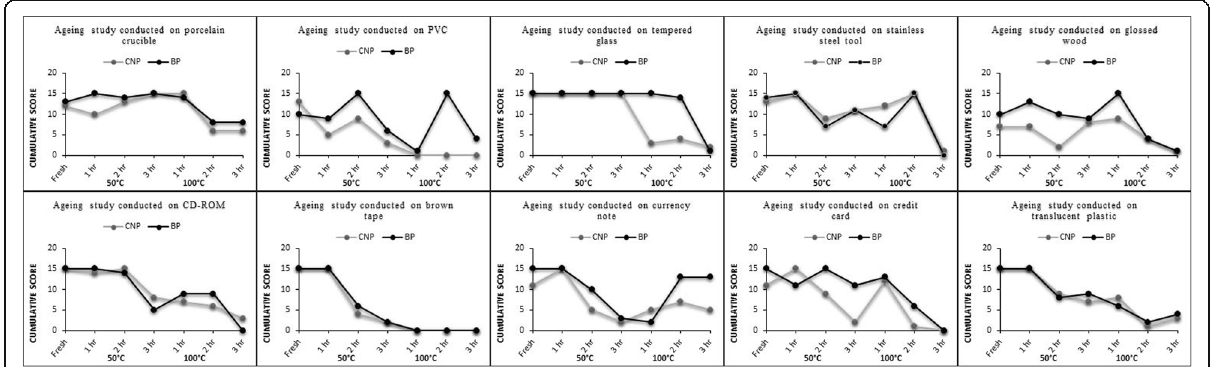
Fig. 9 Line charts that reflect fingermark scores developed with NP and BP for ageing study on non-porous and semi-porous